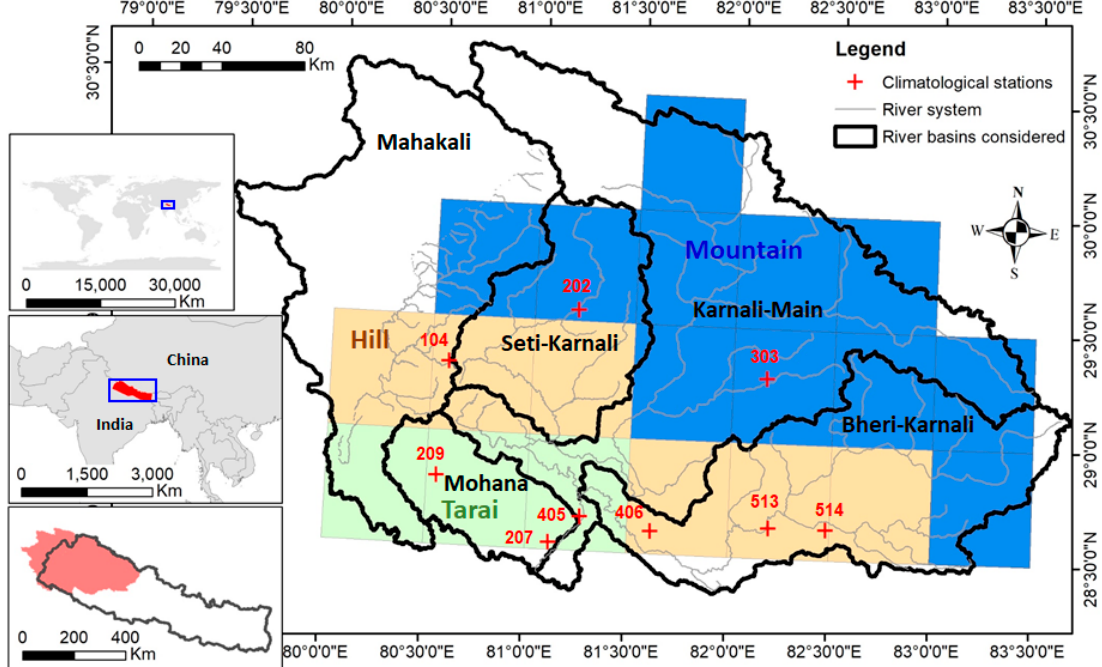
Figure 1. Location of study area in Western Nepal along with other relevant layers. Color squares are regional climate model (RCM) grid cells; blue indicating mountain grids, orange as hill, and green as Tarai grids for future climate projection.